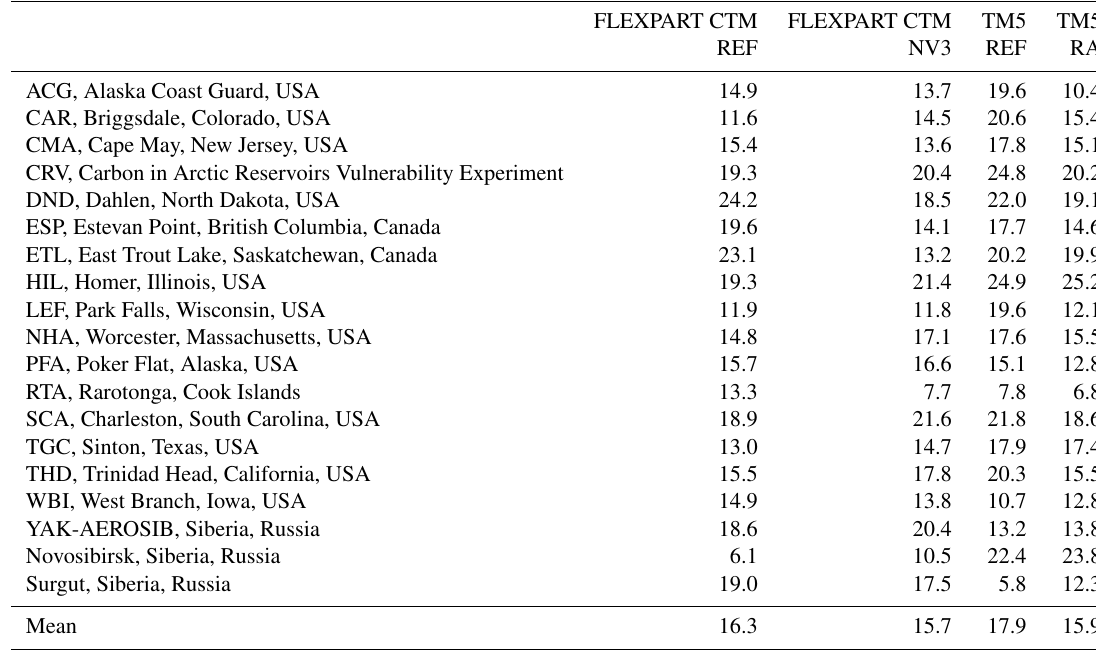
Table 7. RMSE (ppb) of averaged methane profiles at NOAA and NIES profile sites and during the YAK-AEROSIB flight campaign. RMSE is determined with equal weight of each vertical